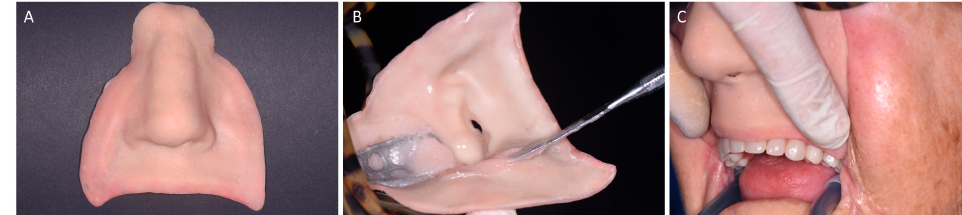
Figure 8. Silicone relining procedure on the patient’s face: external appearance of the prosthesis before the extrinsic coloring ( A ); the relining technique ( B ); the application on the face during the silicone processing ( C ).